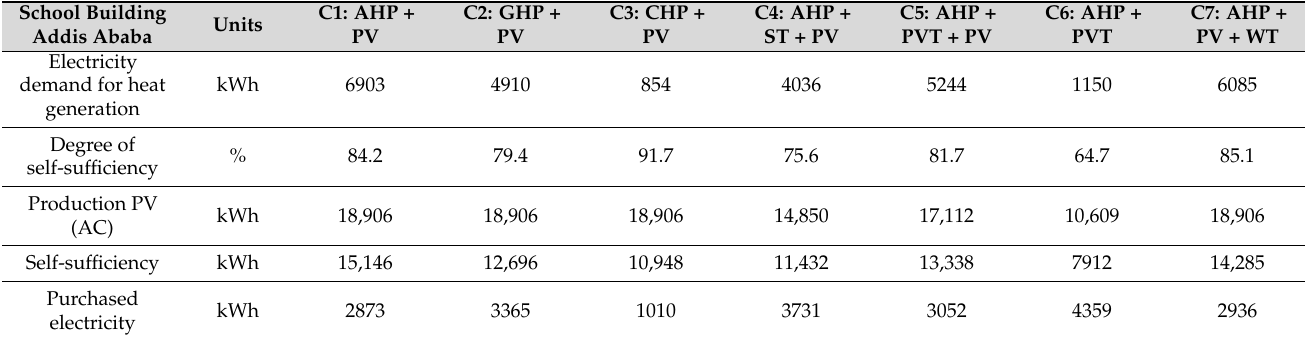
Table 5. Results of the Polysun simulation for the school in Addis Ababa, Ethiopia.